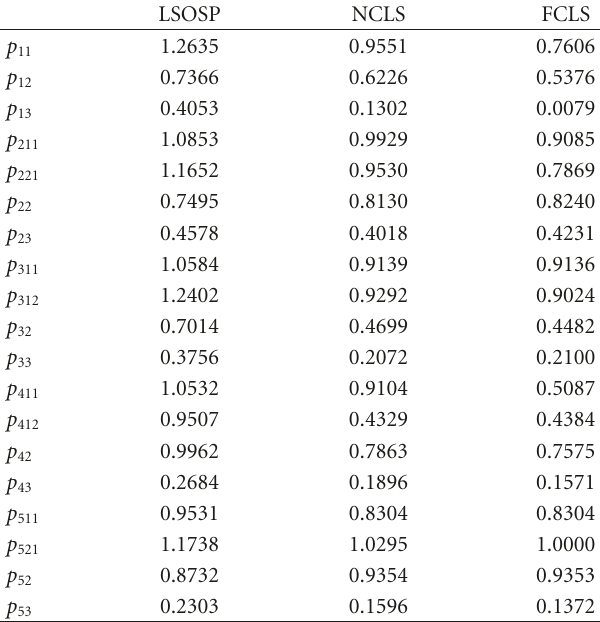
Table 5: Abundance fractions of 19 panel pixels estimated by LSOSP, NCLS, and FCLS using panel signatures in Figure 15(c).